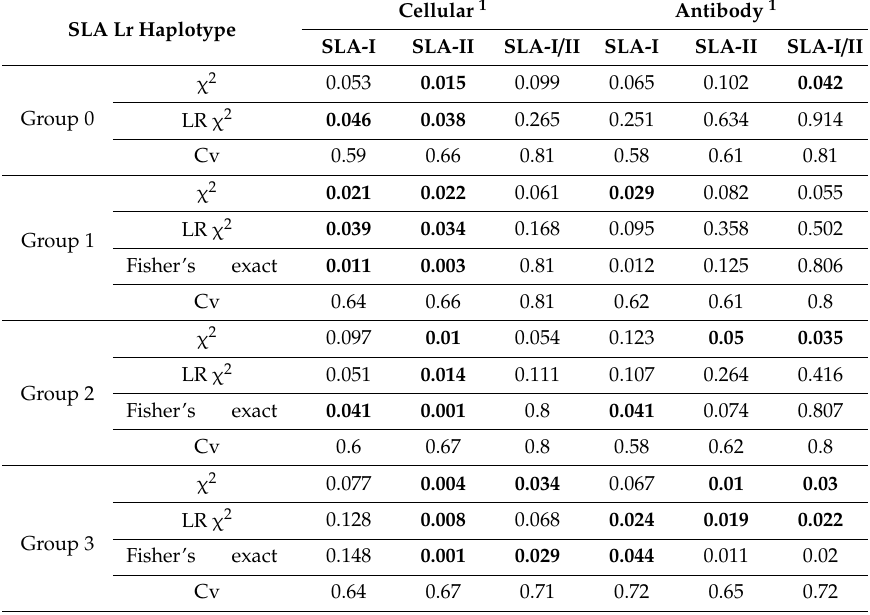
Table 4. Data from statistical tests resulting from analysis of the correlation between antibody / cellular response and Lr-haplotypes in groups 0, 1, 2, and